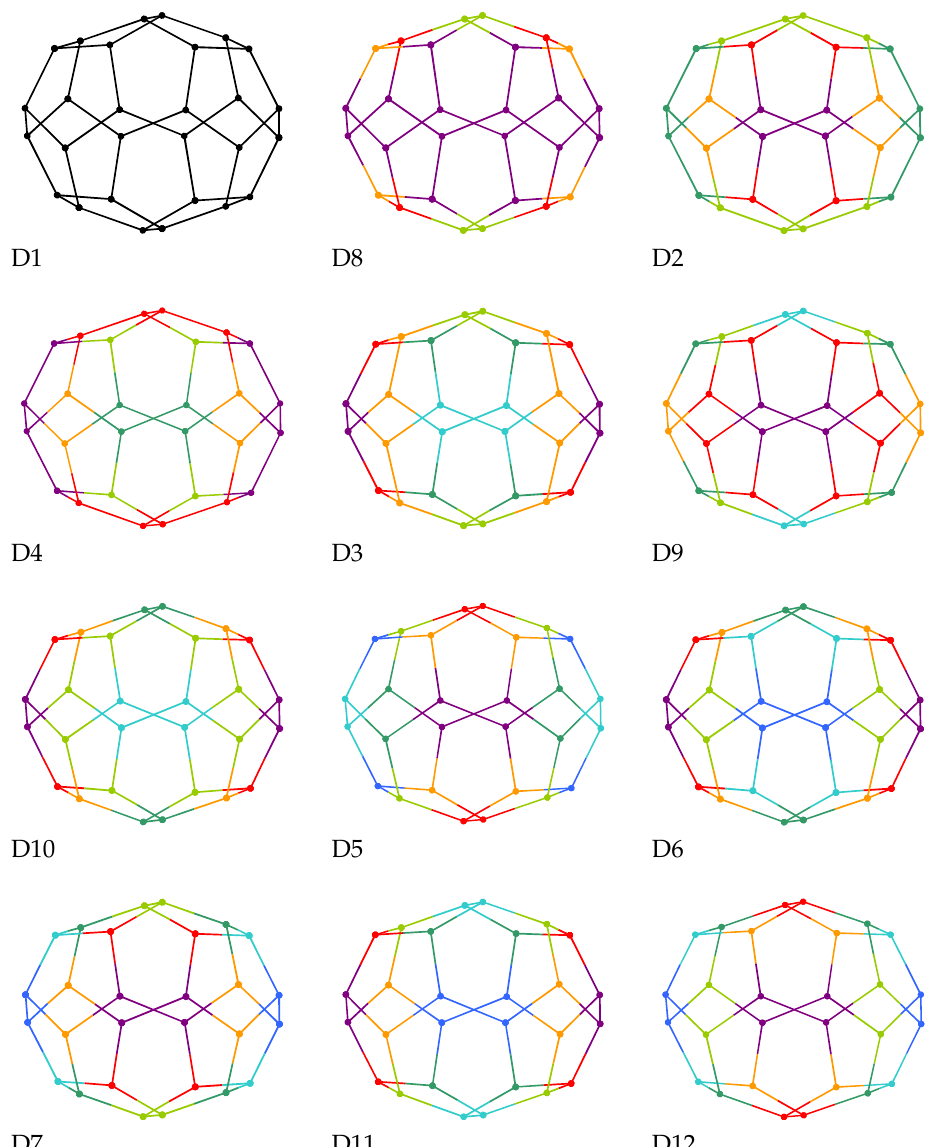
Figure 25. Distinguishable partitions on C 28 − D 2 from Figure